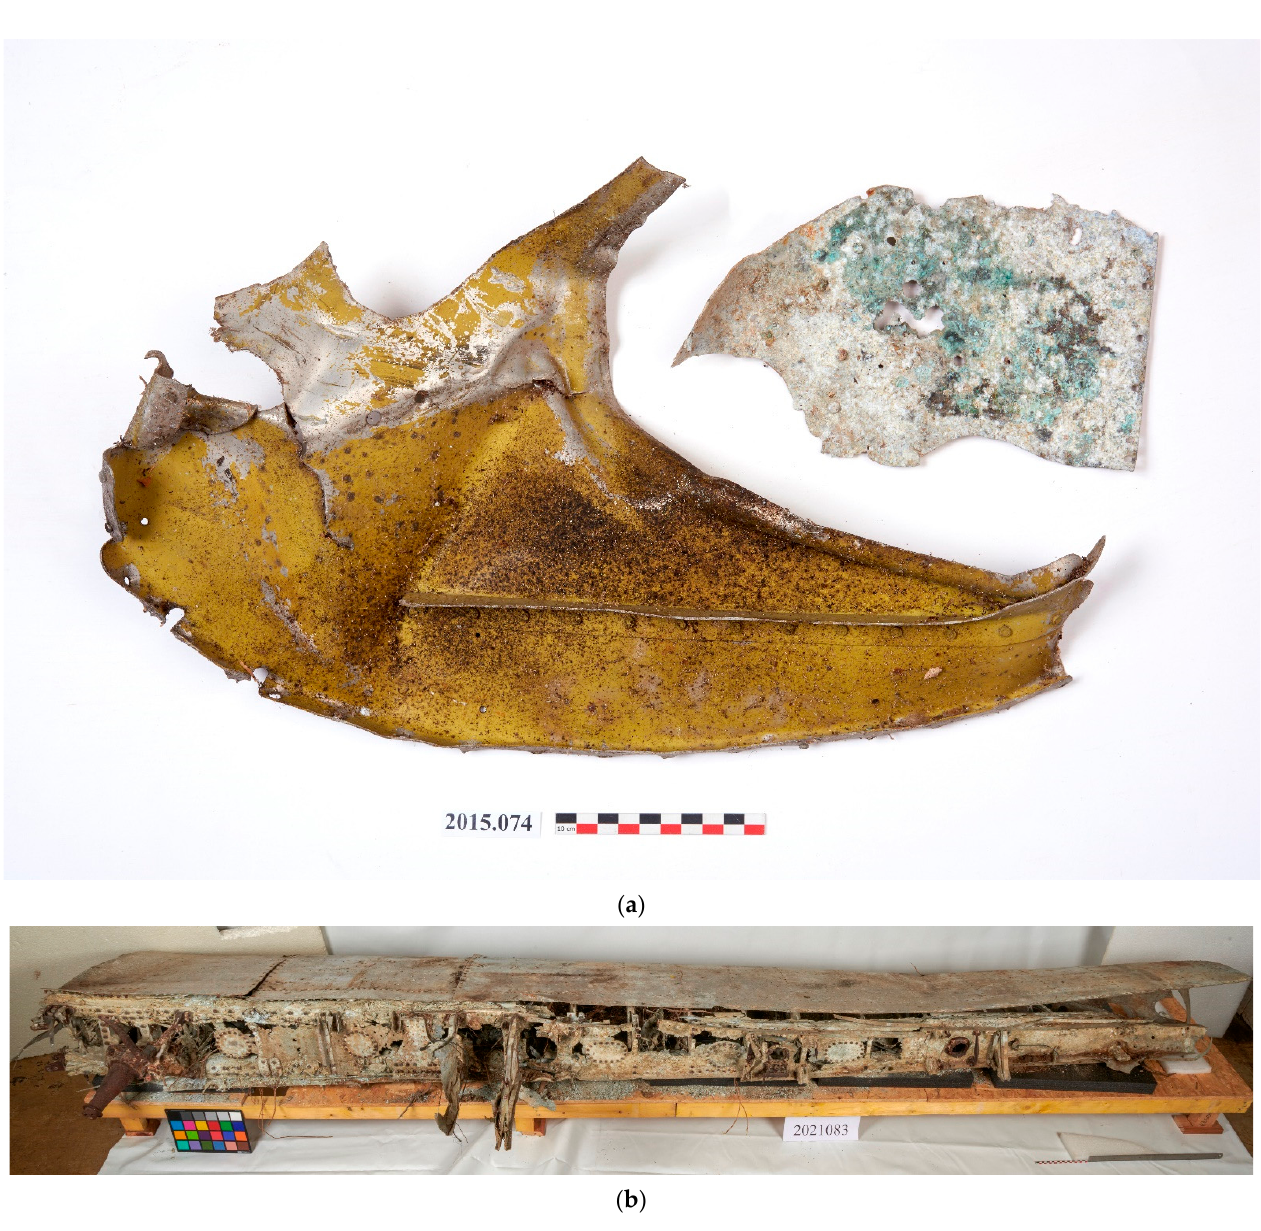
Figure 5. A small plate fragment from a Messerschmitt Bf109 ( a ) and a wing part from a Spit- fire Mk VII MB887 ( b ) (© L. Preud’homme/Arc’Antique—Grand Patrimoine de Loire Atlantique, Nantes,